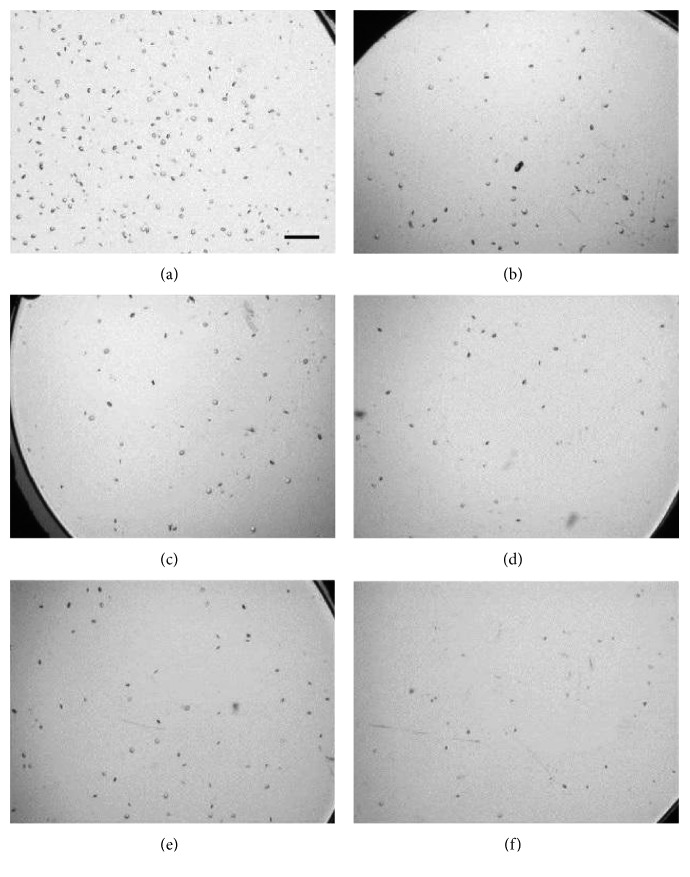
Images of IOL #1 (a), #2 (b), #3 (c), #4 (d), #5 (e), and #6 (f) at 75x magnification. Scale bar, 500 μm.